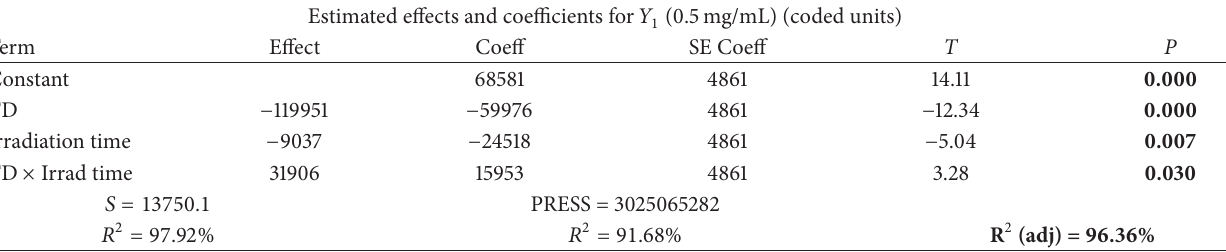
Table 2: ANOVA factorial fit: 𝑌 1 (0.5 mgmL − 1 ) versus TD powder and irradiation time. Estimated effects and coefficients for 𝑌 1 (0.5 mg/mL) (coded